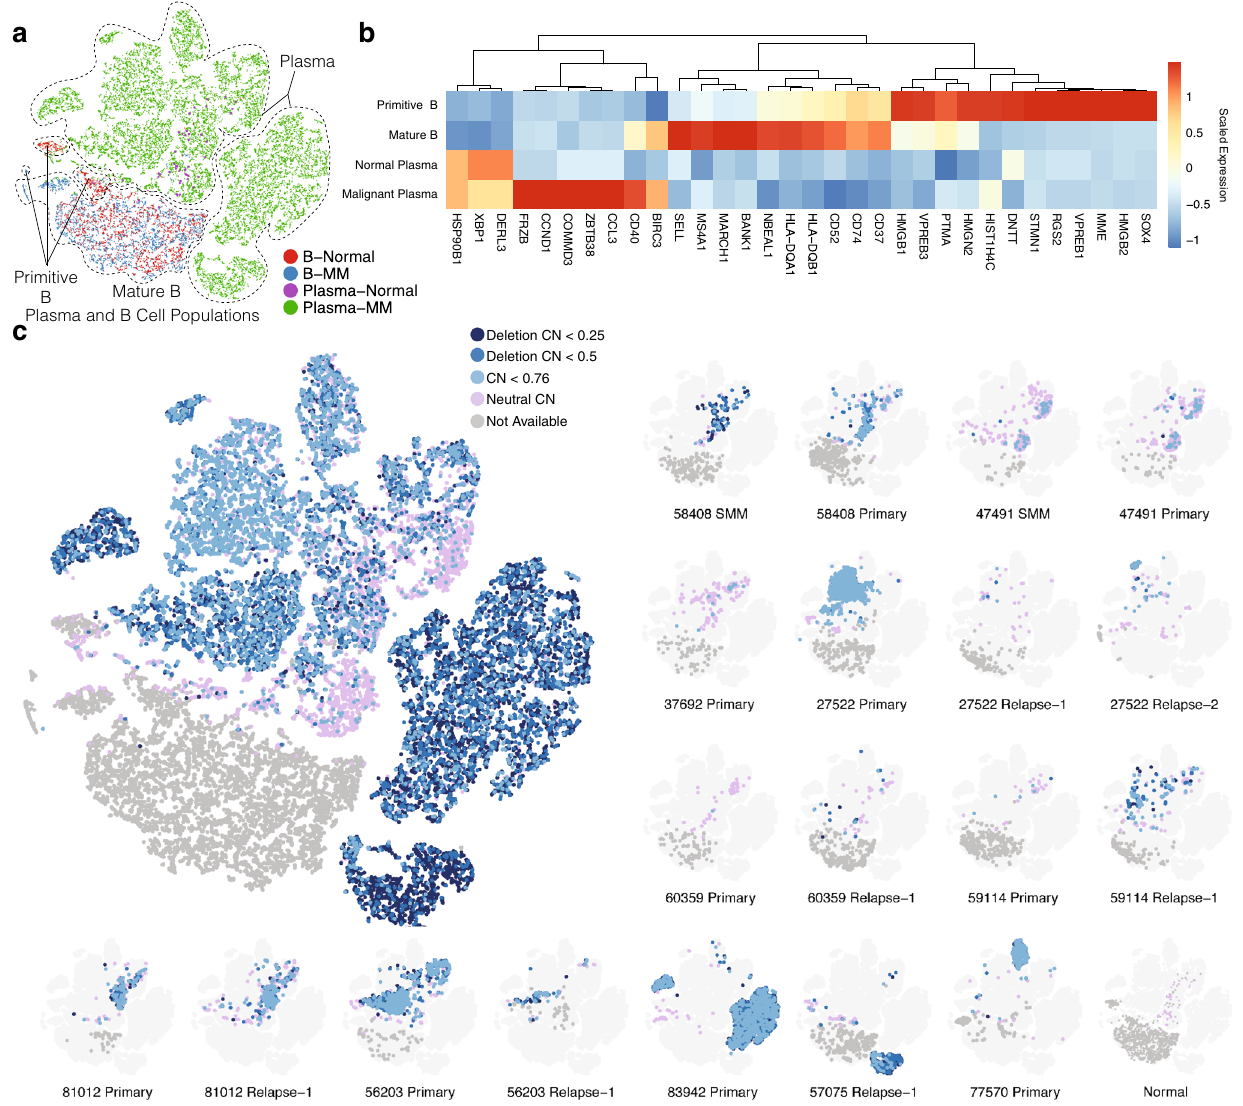
Fig. 3 Analysis of B cell lineage markers and landscape for copy number events. a t-SNE plot showing the distribution of B cells and plasma cells from all patients and four healthy “ normal ” donors. Dots are colored by samples of origin (patients/healthy donors) and cell type. b Heatmap showing genes speci fi cally expressed at certain stages of B cell development. c Landscape of chromosome 13 deletion status showing all samples (left), with sample- speci fi c maps for samples with at least one cell with chromosome 13 copy number (CN) < 0.76 (right). Within each t-SNE plot, dots are colored by chromosome 13 deletion status predicted from inferCNV. Dots colored in grey are B cells with CNV scores